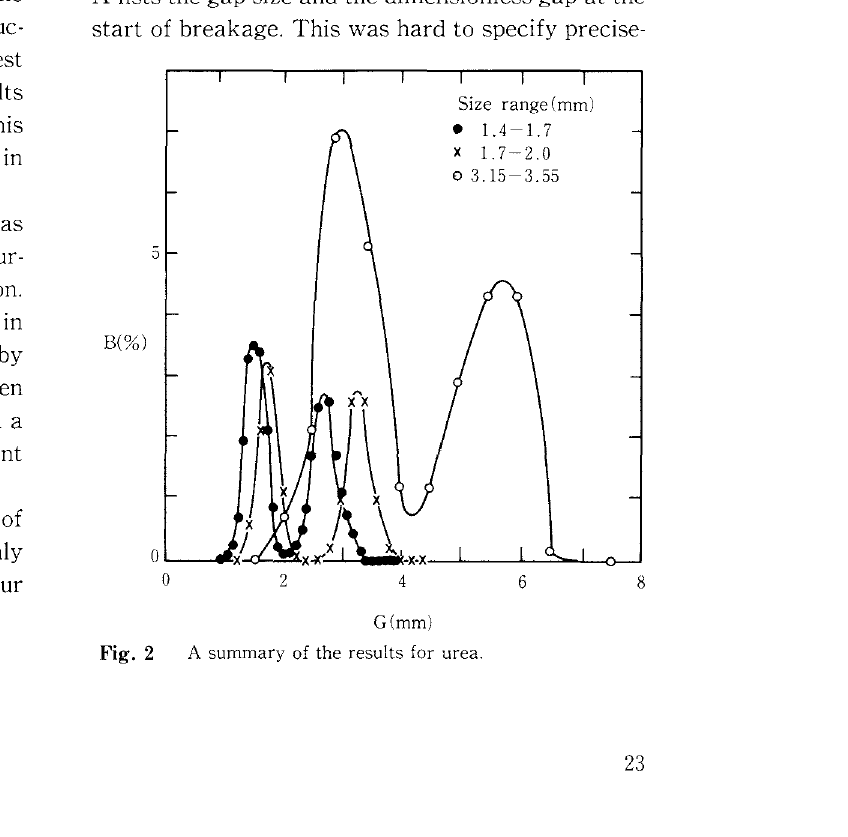
Fig. 2 A summary of the results for